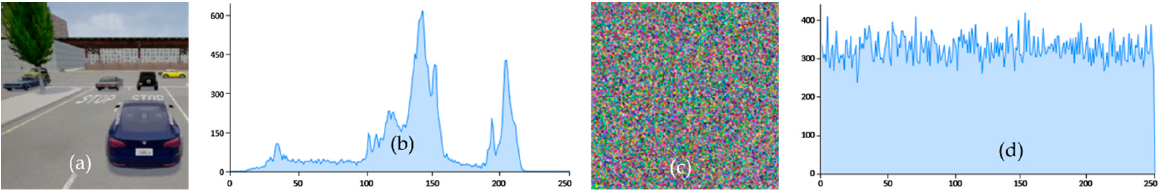
Figure 9. Histograms of original and encrypted image frames. ( a ) represents the original sample image frame, ( b ) depicts the histogram of the original image while ( c ) represents the encrypted image frame, and ( d ) is the depiction of the histogram of the encrypted image frame.